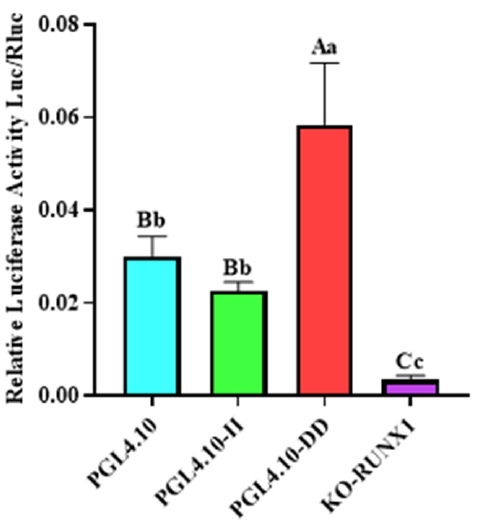
Figure 3. The dual-luciferase activity of GHR-SV246 recombinant plasmid in 293T cells. 3.6. mRNA Expression Profile of the GHR Gene in Yak The expression levels of the GHR gene in different tissues were identified in yaks. There were significant differences in the expression of the GHR gene in various tissues of yaks, with the highest expression in fat, followed by the liver, muscle, and kidney tissues, and the lowest expression in the heart, spleen, and lung tissues (Figure